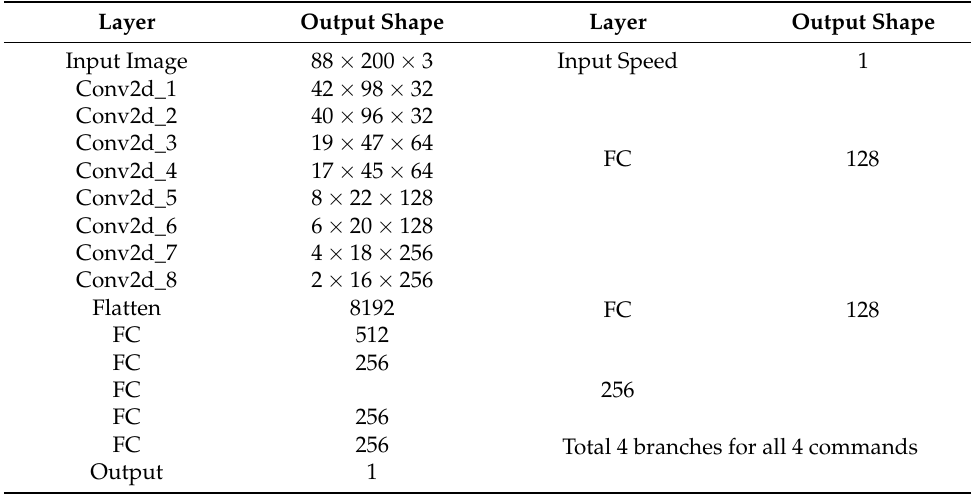
Figure 2. Early Fusion of Multi-modal Structure Diagram. Table 1. Network